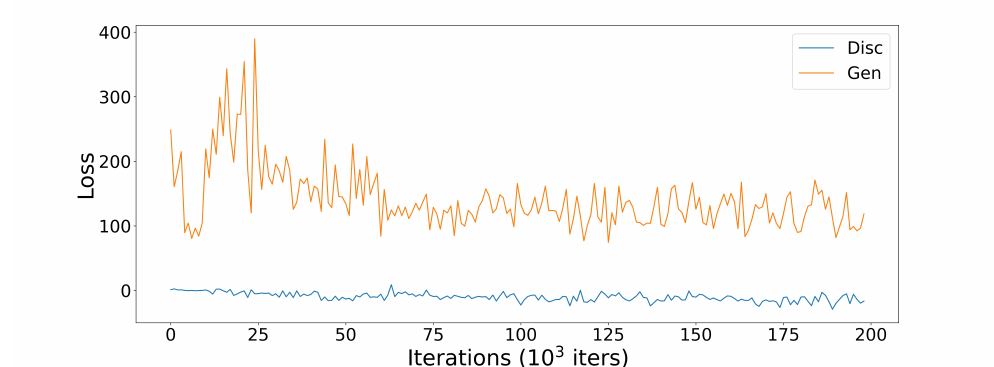
Figure 8. Discriminator (blue) and Generator (orange) loss function plots of the α -WGANSigmaRat2 model training process.